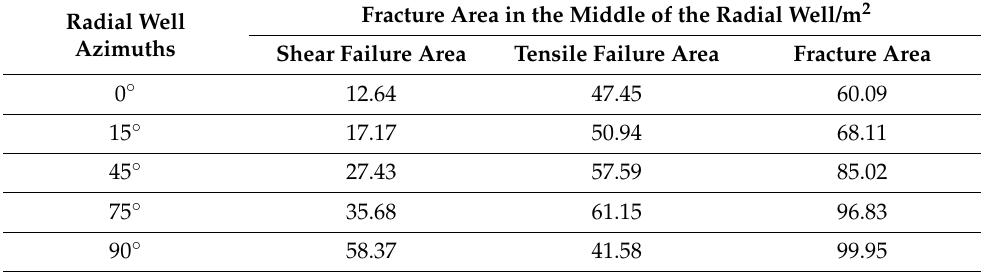
Figure 7. Fracture morphology at the deflagration point under different radial well azimuths. Table 5. Fracture characterization under different radial well